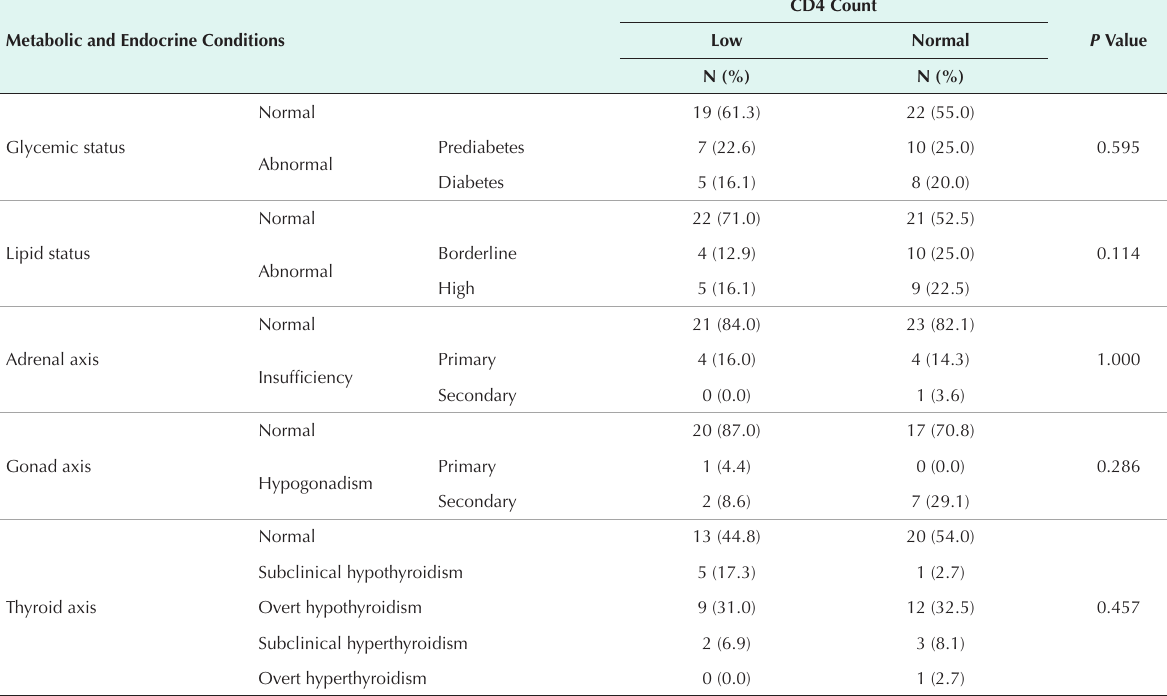
Table 5. Metabolic and Endocrine Disorders by CD4 Count in HIV-positive Patients